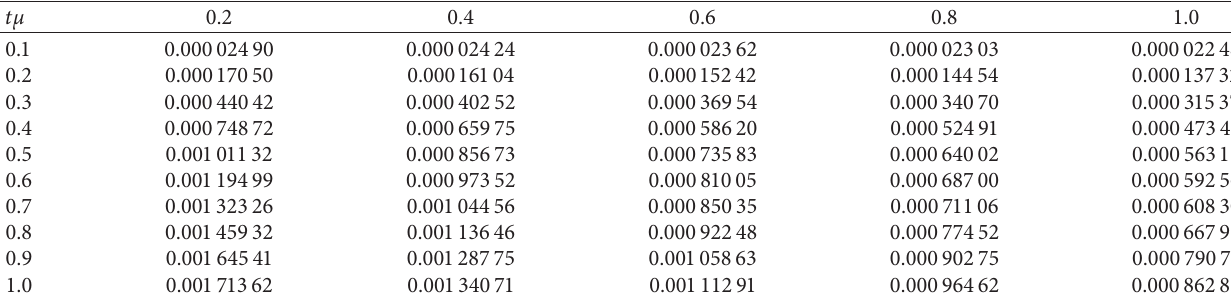
Table 3: Some values of w ( t, x ) for different values of μ for P � 1 (for a polybutadiene beam).